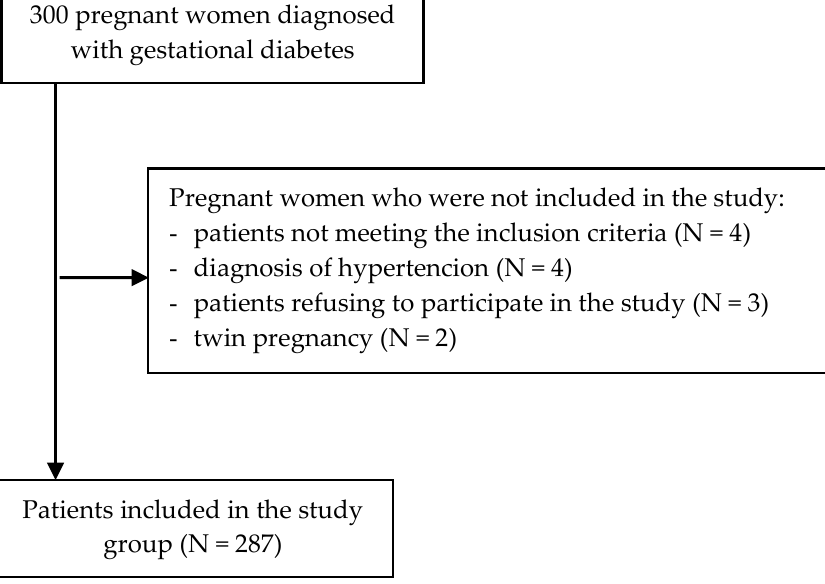
Figure 1. Flowchart of the recruitment process of the patients. The Polish Society of Gynecologists and Obstetricians and Polish Diabetes Association criteria were used to diagnose GDM when any of the following criteria were met on OGTT: fasting blood glucose between 92–125 mg/dL, 60th-minute blood glucose ≥ 180 mg/dL, 120th-minute blood glucose between 153–199 mg/dL